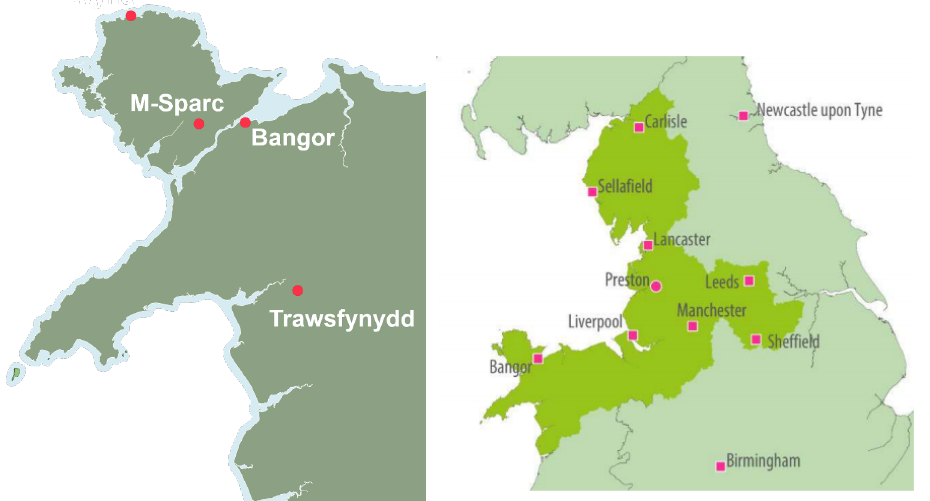
Figure 2: [Left] North Wales Low Carbon Triangle: Bangor-Anglesey-Trawsfynydd [Right] Definition of the North West Nuclear